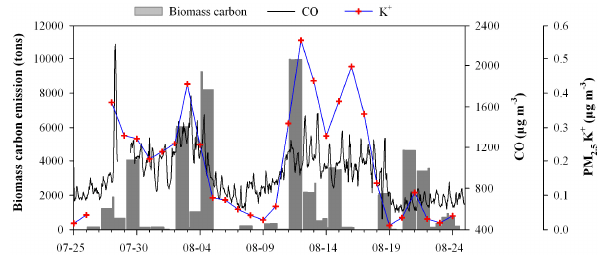
Fig. 6. Hourly CO concentration (µgm − 3 ), hourly biomass carbon Figure 6. Hourly CO concentration ( μ gm -3 ), hourly biomass carbon emission (tons/hr) from the FLAMBE biomass burning emission inventory in the domain of 28 – 32 °N, 119 – 123°E in Eastern emission (tonsh − 1 ) from the FLAMBE biomass burning emission China with daily K + concentration in PM 2.5 during the summer of 2010. inventory in the domain of 28–32 ◦ N, 119–123 ◦ E in eastern China with daily K + concentration in PM 2 . 5 during the summer of